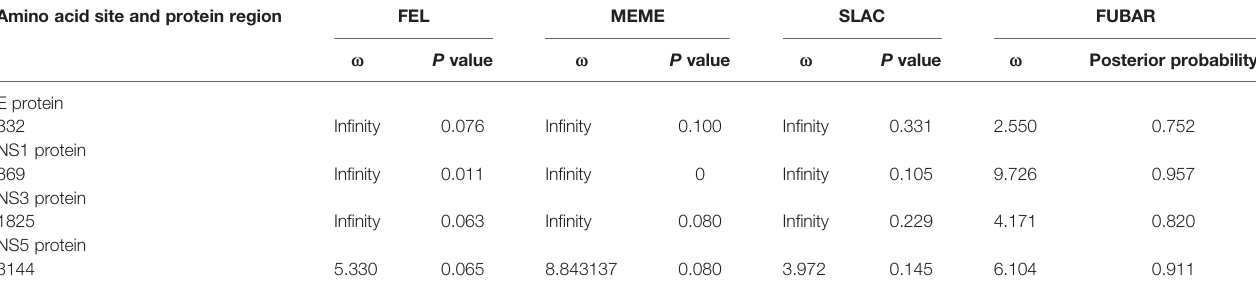
TABLE 3 | Selection pressure analysis of the ORF (3391 codons) of DENV-1 using FEL, MEME, SLAC, and FUBAR. Amino acid site and protein